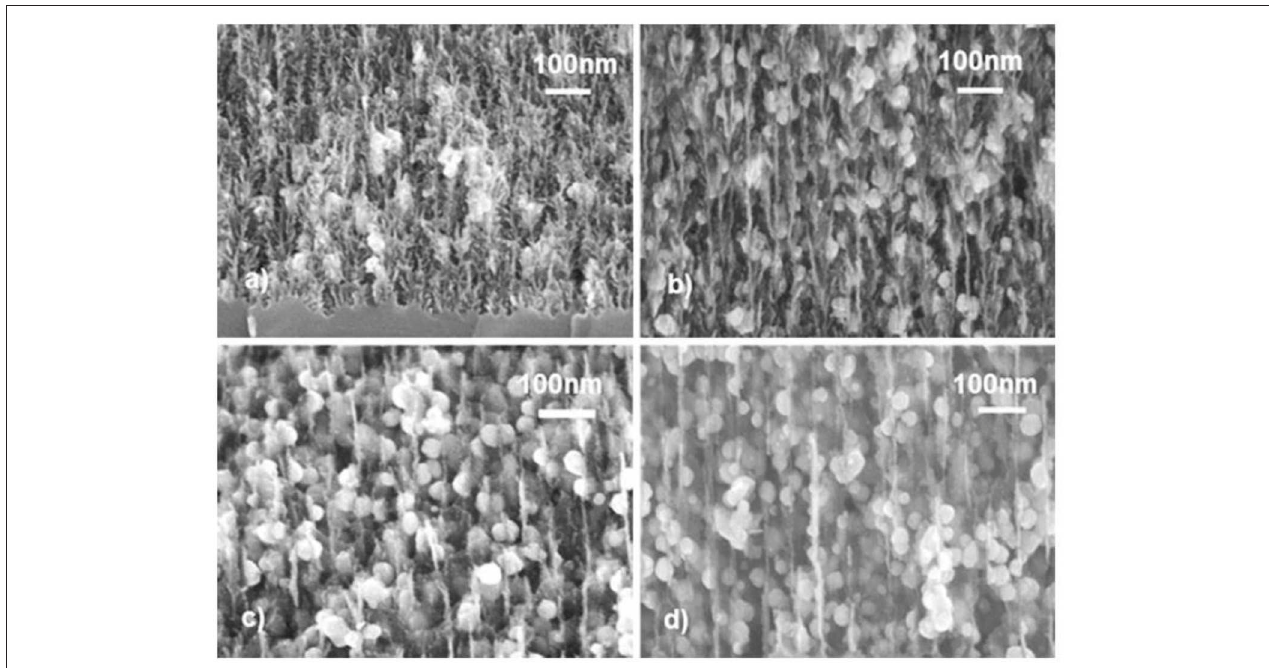
FIGURE 11 | Cross-sectional scanning electron micrographs of porous silicon offering different morphologies with infiltrated Ni structures. The Ni deposition depends on the porous silicon porosity and it can be seen that for lower porosity the Ni particles are smaller than in the case of higher porosity. This behavior is due to faster exhaustion of the electrolyte and thus a longer growth time. Michelakaki et al. [ 80], Springer Nature with permission. In (a,b) , the samples offer a porosity of about 70% and the Ni nanoparticle size is ∼ 23 nm. With increasing porosity to 86% and 88% shown in (c,d) , the Ni particle size increases to about